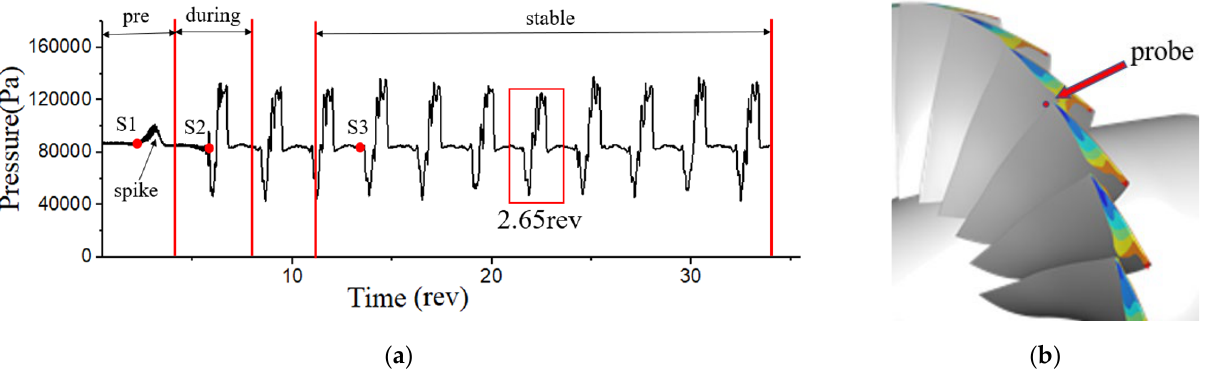
Figure 6. Pressure of a probe in front of the tip leading edge. ( a ) Pressure at probe. ( b ) Probe loca- tion.